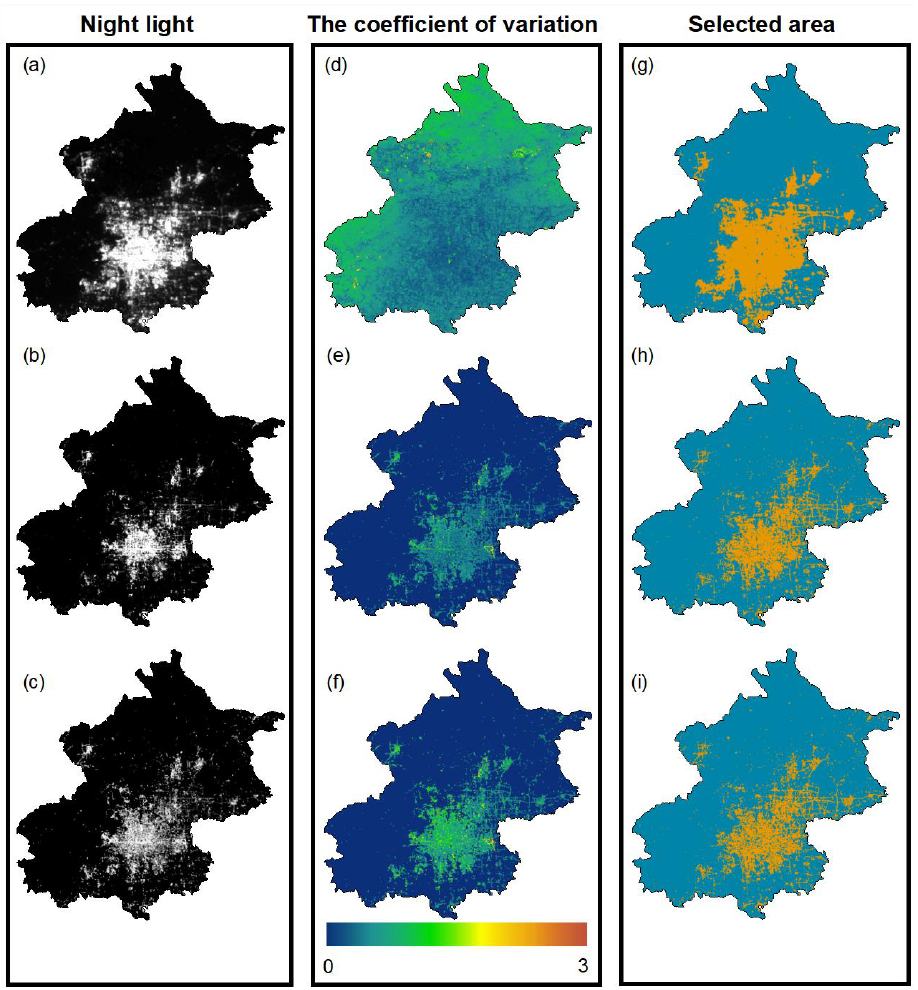
Figure 3. The selection of urban nightlight regions for AOD derivation based on the coefficient of variation (CV). Regions with high CV values were not used in AOD inversion due to the unstable light variation. ( a , d , g ) show the radiance background from VIIRS/DNB in March 2022, the variation coefficient image, and the selected area for AOD derivation at night, respectively. ( b , e , h ) provide the background light synthesized by SDGSAT-1/GLI images, the variation coefficient image, and the selected area for AOD derivation based on the radiation transfer method, respectively. ( c , f , i ) are the background light synthesized by SDGSAT-1/GLI images, the coefficient of variation images, and the selected area for AOD derivation based on the standard deviation method, respectively.